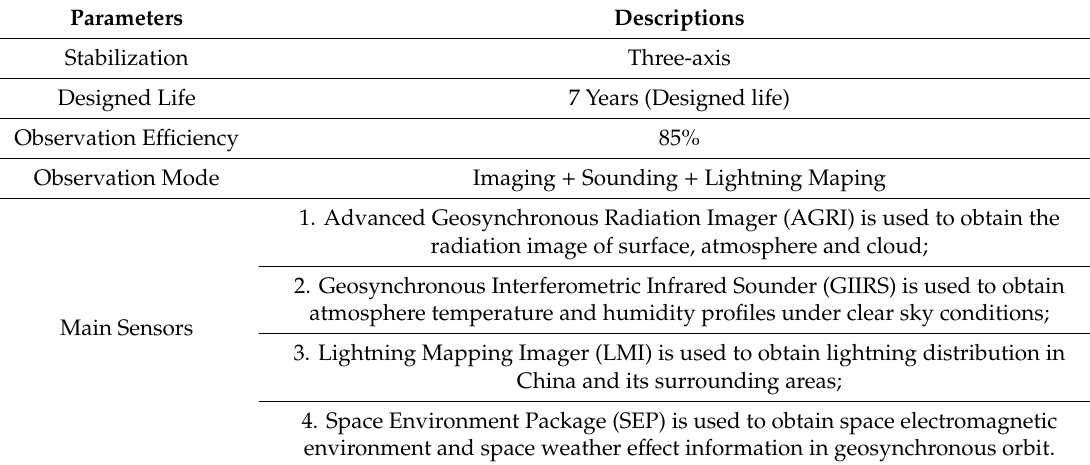
Table 1. The observation parameters and main sensors of